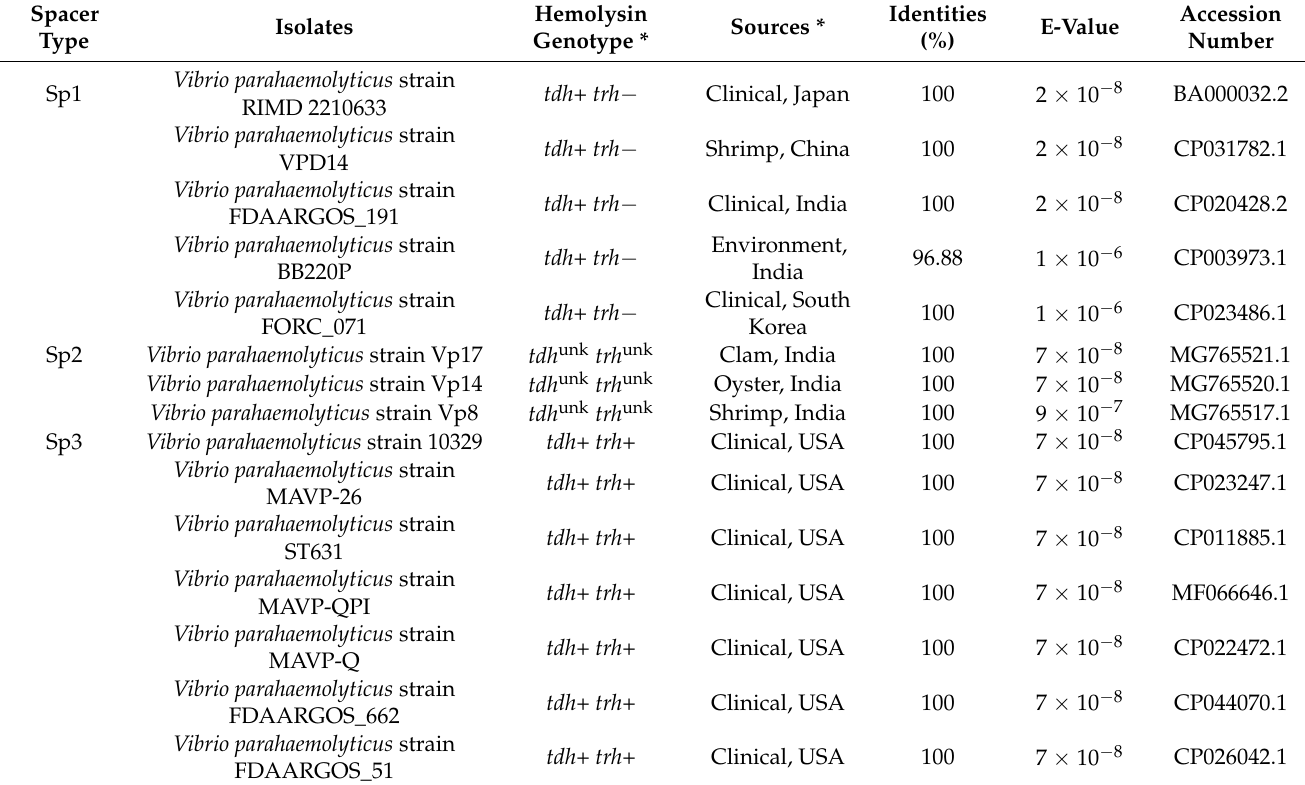
Table 5. Homology analysis of the Sp1 to Sp4 spacers against public genomes of V. parahaemolyticus